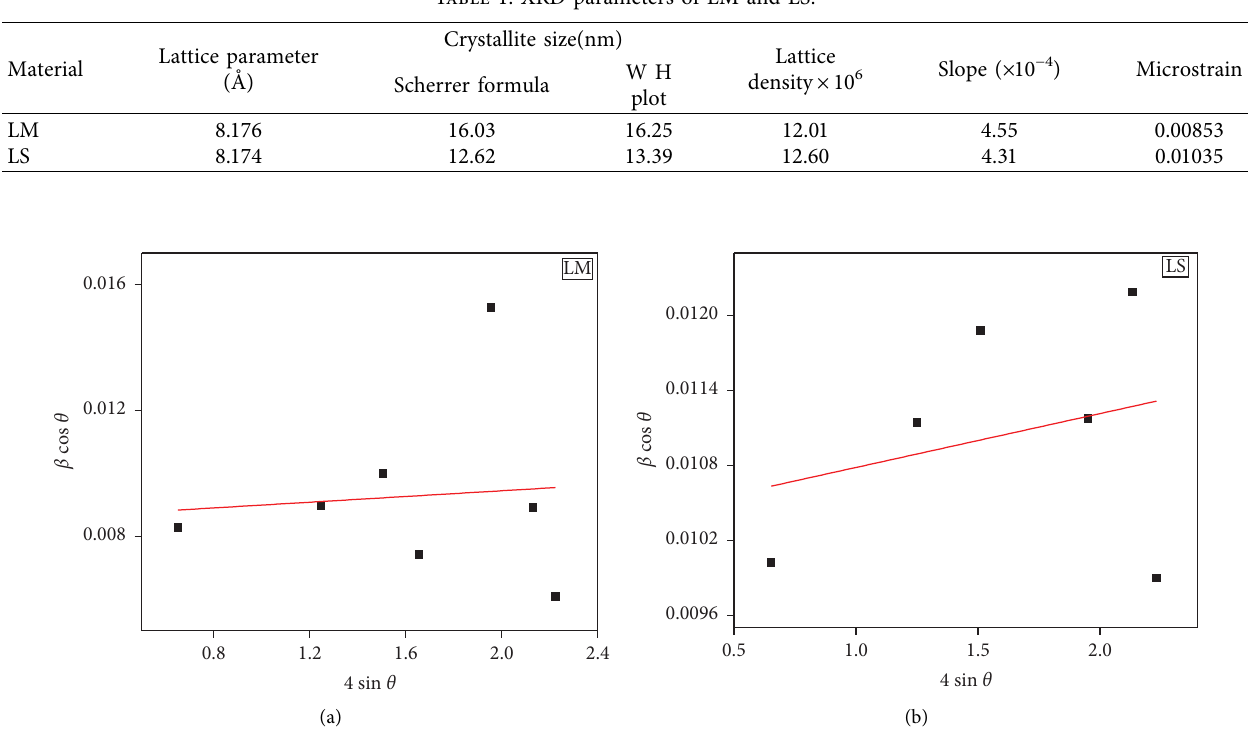
Figure 2: W-H plot of (a) Li 4 Mn 5 O 12 and (b) Li 4 Mn 4.75 Sm 0.25 O 12 .